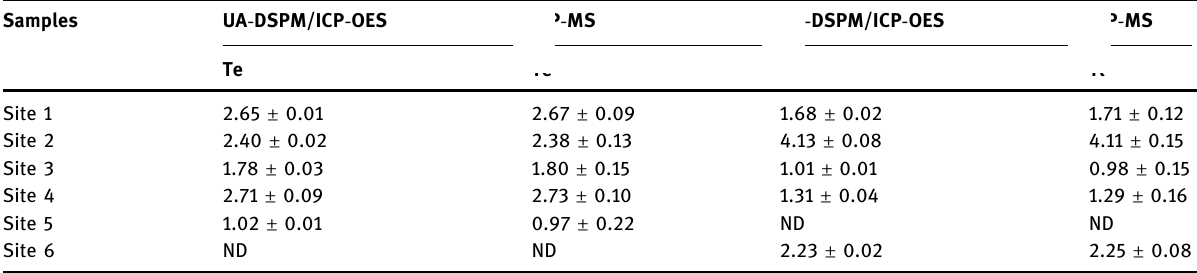
Table 5: Determination of Te and Tl in real samples ( mean ± SD, n = 4 )